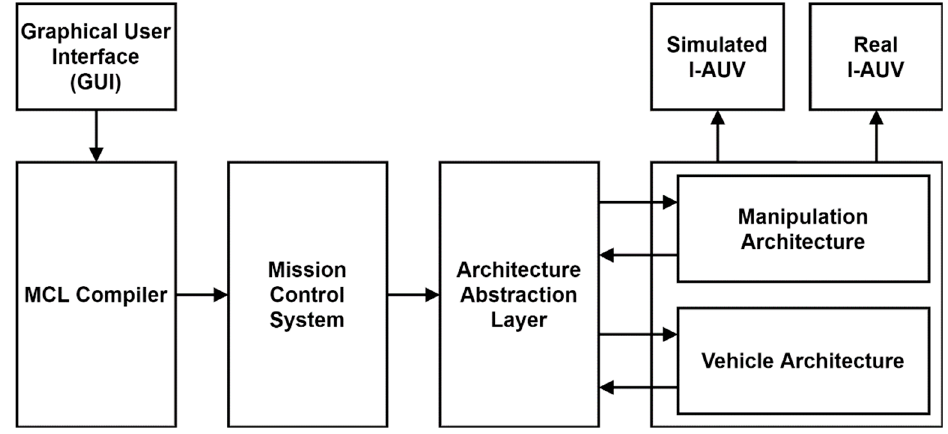
Figure 11. An overview of the RAUVI software architecture.